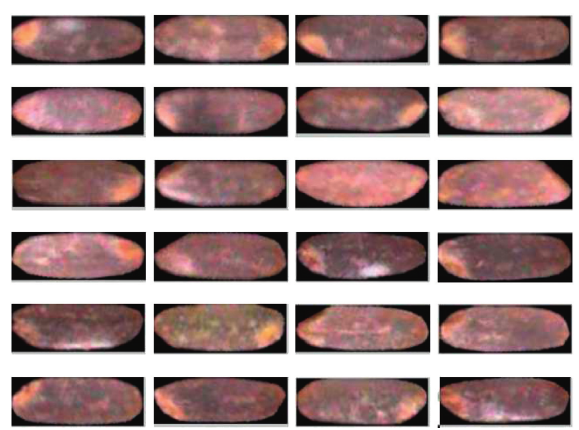
Figure 28: Single grain rice extraction image after segmentation. Table 1: The classic range-transformation watershed algorithm segmentation result.